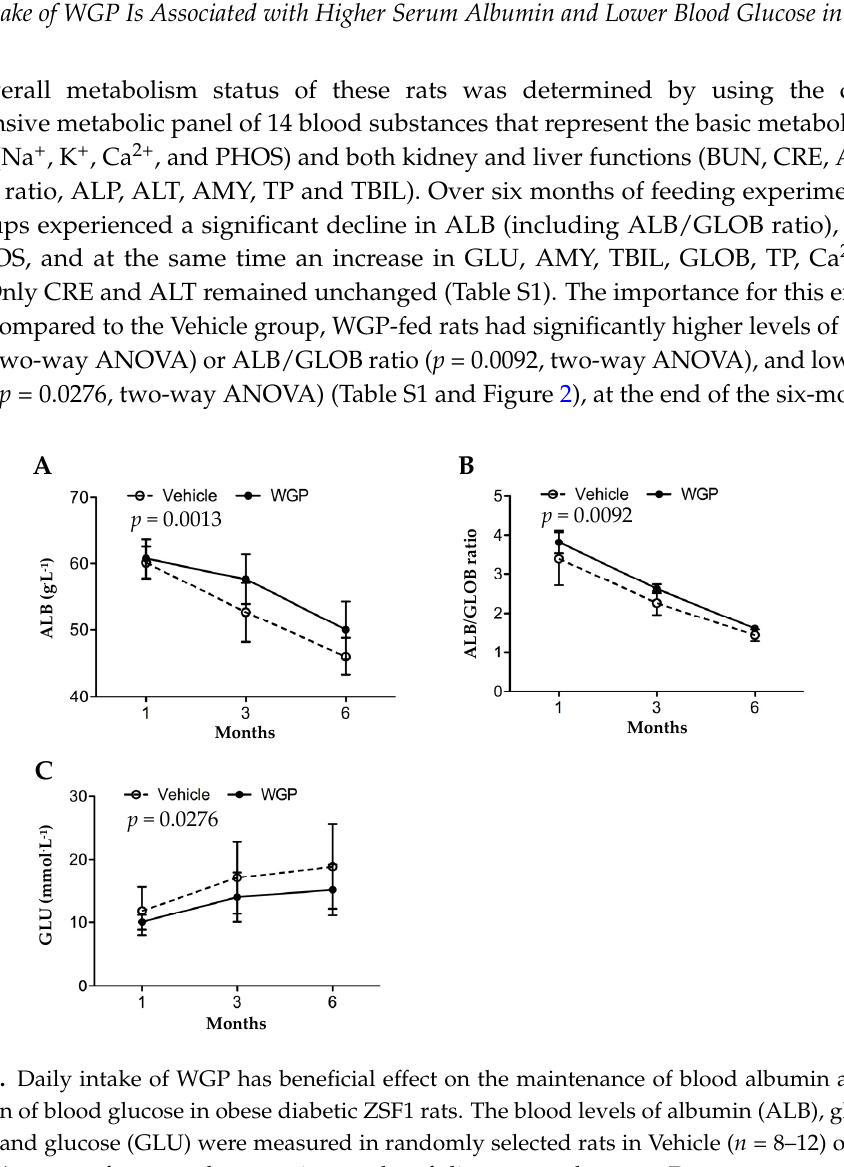
Table 1. Organ index (organ weight/bodyweight) after six months of feeding sugar (Vehicle) or whole grape powder (WGP). Figure 1. No effect of daily intake of whole grape powder (WGP) on bodyweight gain or obesity in obese diabetic ZSF1 rats.